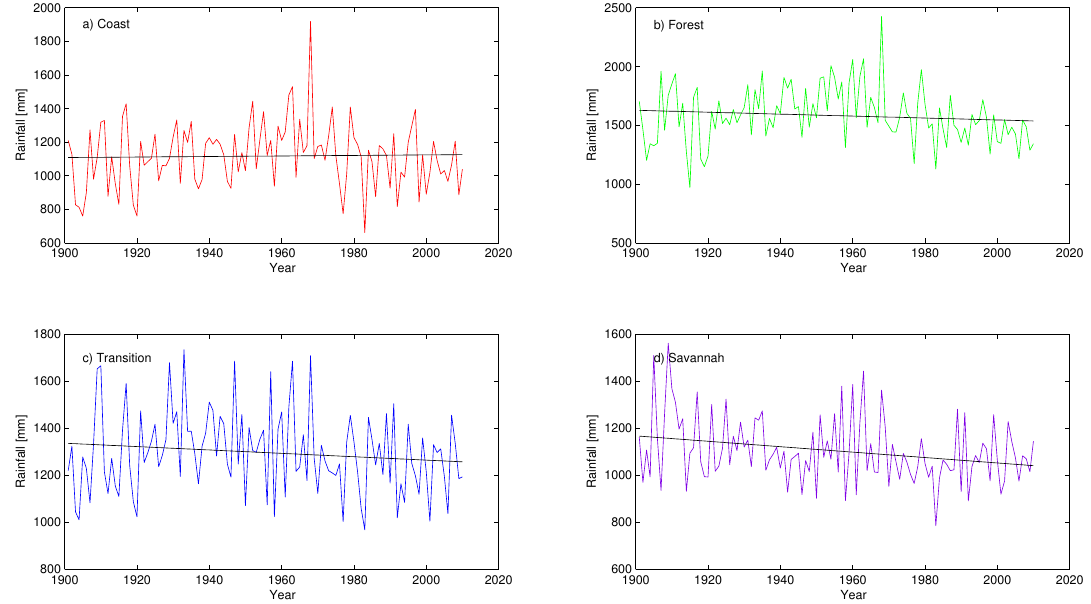
Figure 12. ( a – d ) Long-term course of annual rainfall over the agro-ecological zones of Ghana.